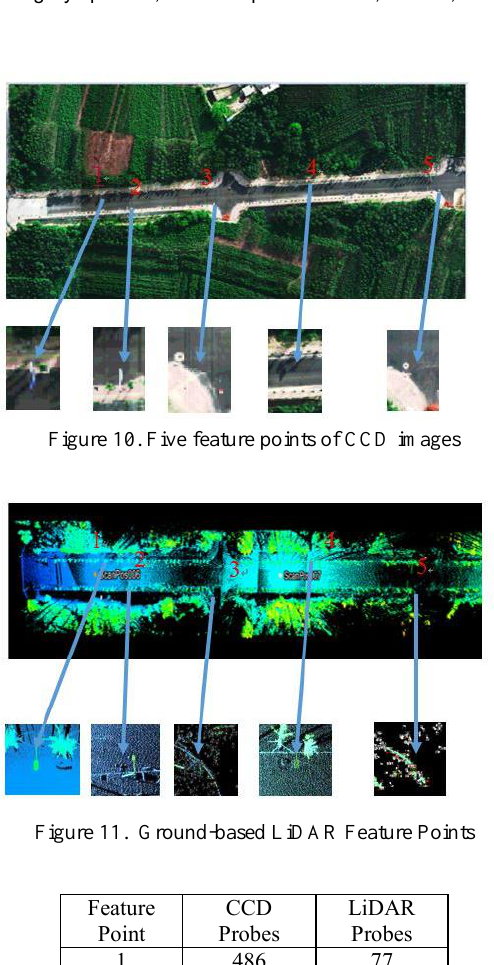
Figure 9. Fight area and the place used for flight dynamics calibration